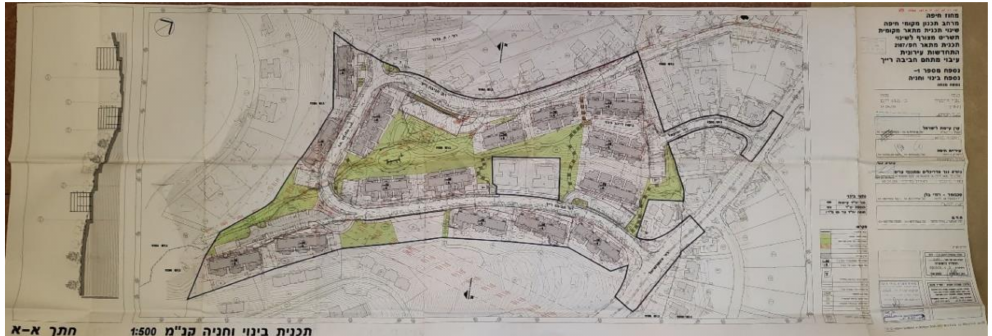
Figure 5. Construction and parking plan. The Haviva Reich Construction and Parking Plan. Planners: Giora Gur Architects. Source: the Haifa municipal